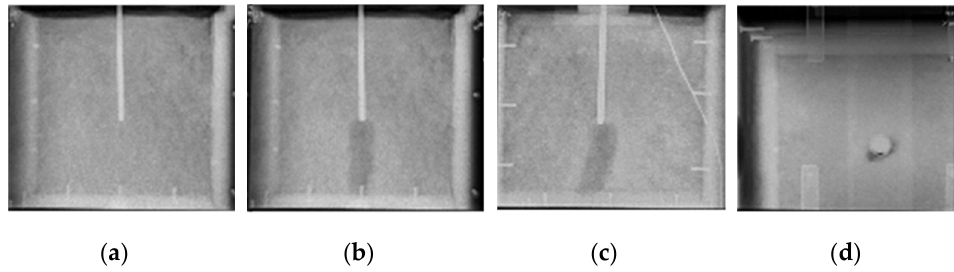
Figure 18. Images of modified soil with water content of 15%: ( a ) Before breakdown; ( b ) front view; ( c ) side view; ( d ) top view.